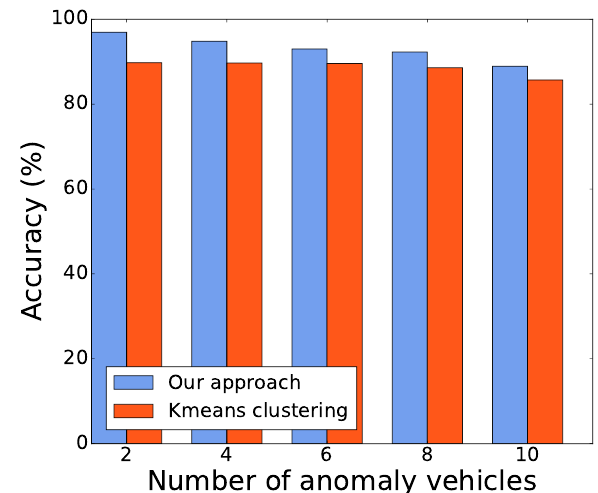
Figure 6. Detection accuracy